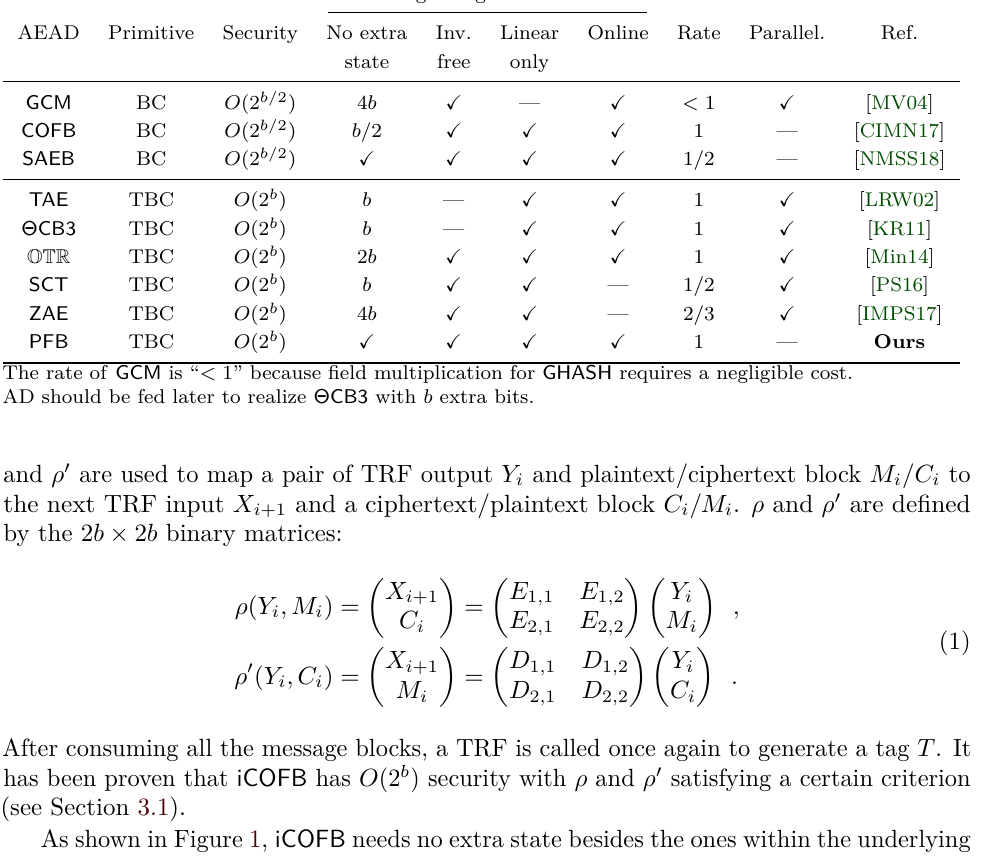
Table 1: Lightweight criteria [NMSS18] and AEAD modes. BC indicates block cipher. The “No extra state” column shows the number of extra bits if the criterion is not satisfied. Lightweight criteria AEAD Primitive Security No extra Inv. Linear Online Rate Parallel.